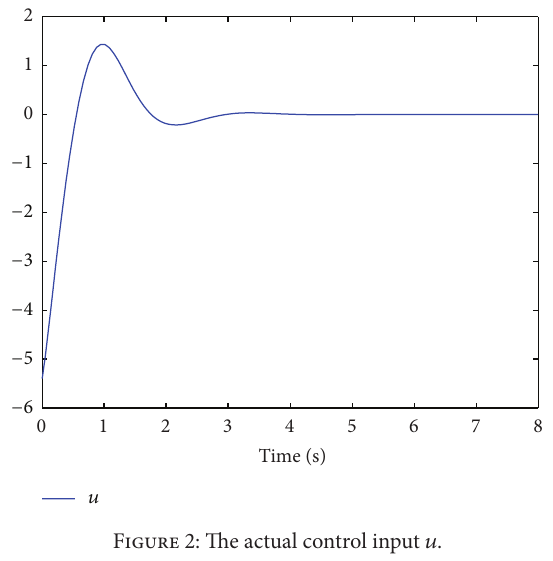
Figure 2: The actual control input 𝑢 .